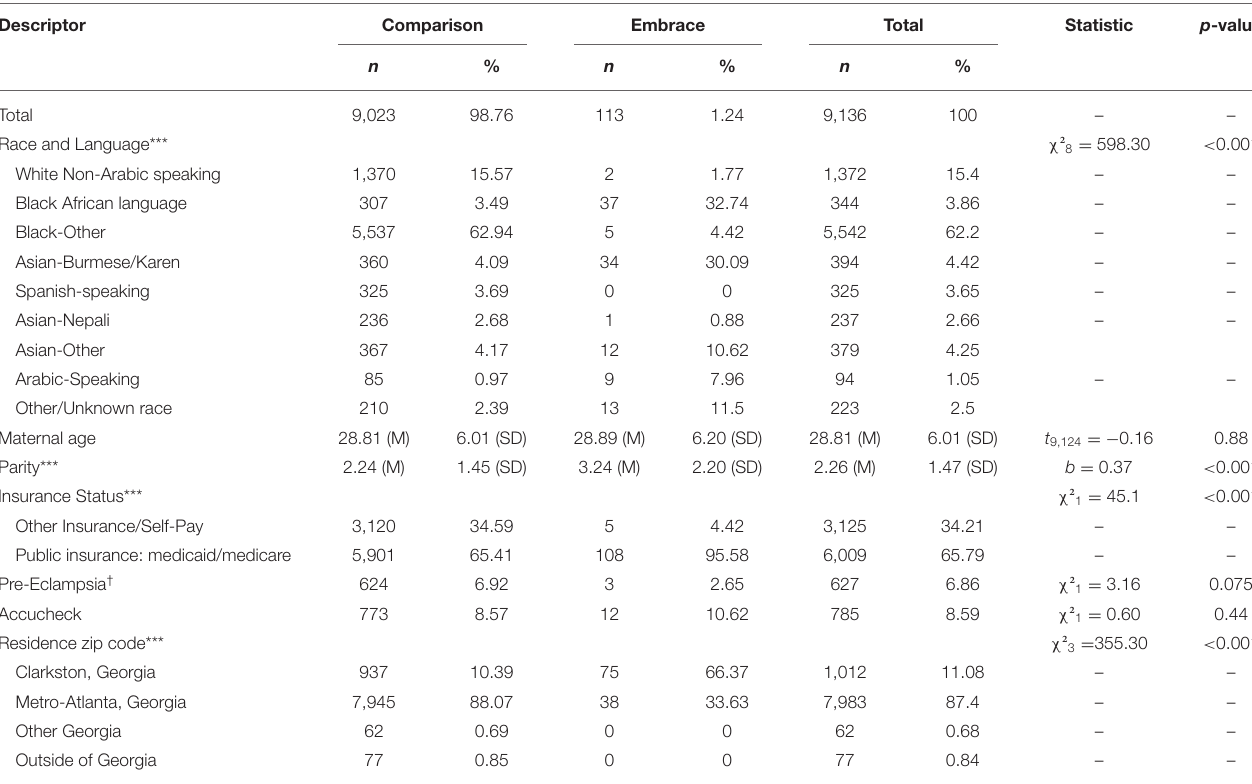
TABLE 1 | Descriptive statistics of the Embrace participants and comparison group at Emory Decatur Hospital from 2016 to 2018.